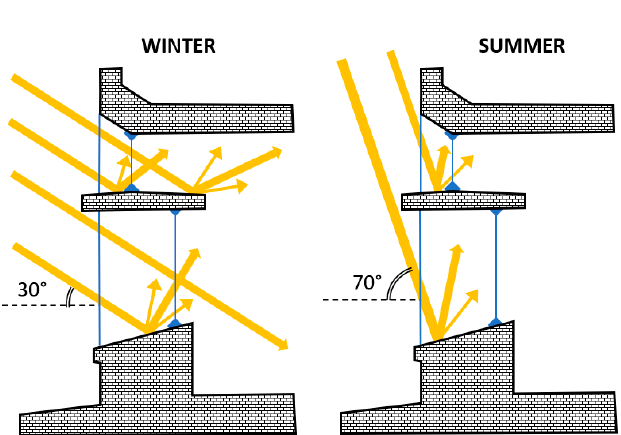
Figure 7. Sun’s rays’ orientation (winter and summer) through the use of a light shelf.